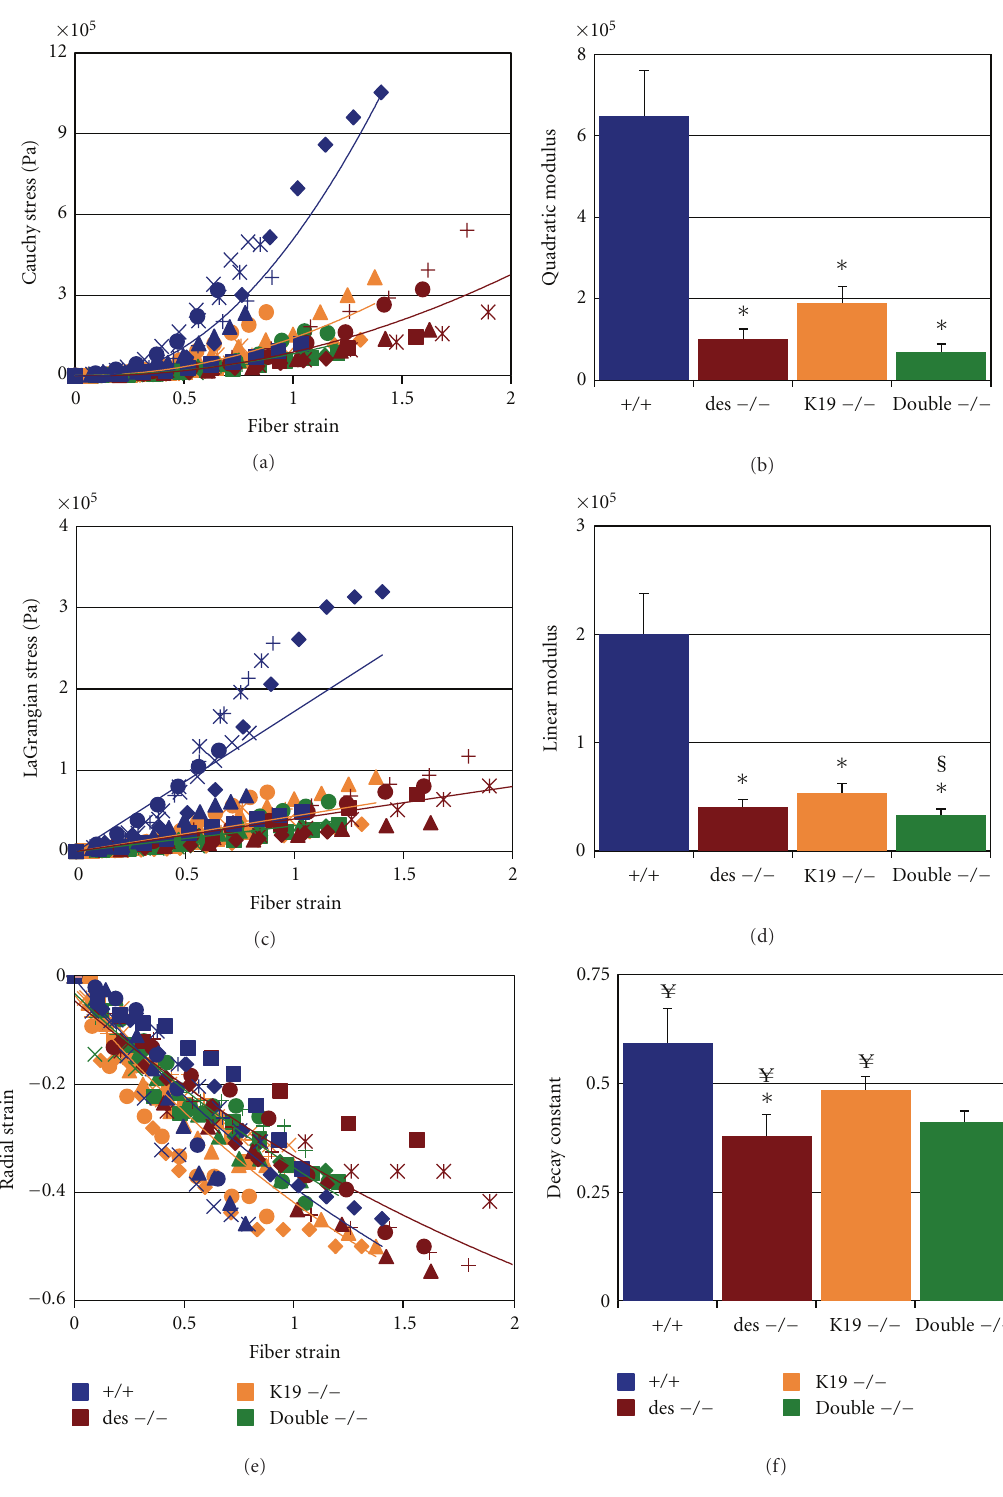
Figure 1: Mechanical response of fibers from aged animals. Raw data (a, c, e) and regression coe ffi cients (b, d, f) for (a-b) Cauchy stress-fiber strain (quadratic regression); (c-d) LaGrangian stress-fiber strain (linear regression); (e-f) radial strain-fiber strain (exponential regression) for fibers from 10-month-old wild-type (blue), desmin-null (red), K19-null (orange), and double-null (green) animals ( n = 7 fibers/genotype). Di ff erent symbols within a color group represent data from individual experiments. Displayed regression lines in (a), (c), and (e) represent averaged coe ffi cients for individual experiments reported in (b), (d), and (f). ∗ Indicates significant di ff erence from wild- type; § indicates significant di ff erence from K19-null; (cid:2) indicates significant di ff erence from corresponding genotype in younger animals. P values are reported in the